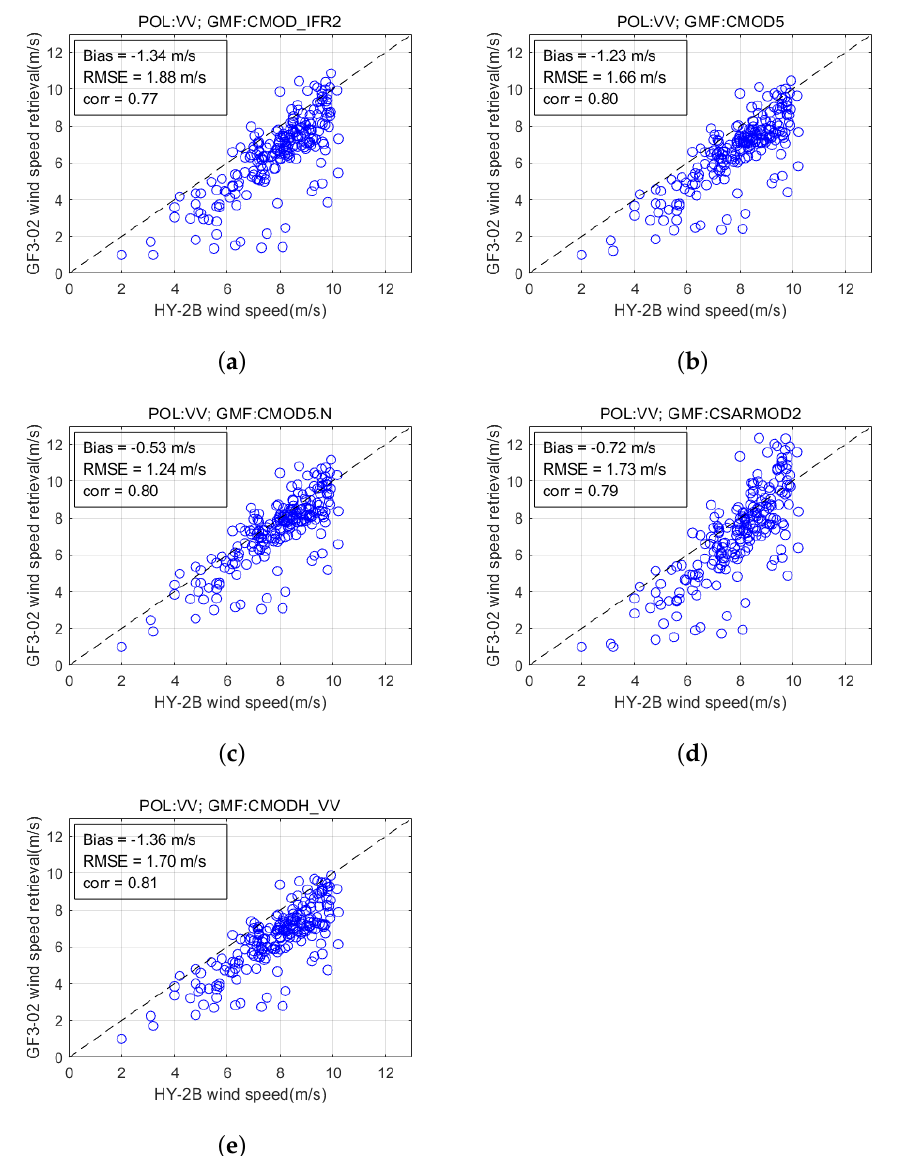
Figure 5. Comparison of wind speed retrieval results from GF3-02 VV polarization data based on ( a ) CMOD_IFR2, ( b ) CMOD5, ( c ) CMOD5.N, ( d ) CSARMOD2, and ( e ) CMODH_VV and HY-2B SCA wind